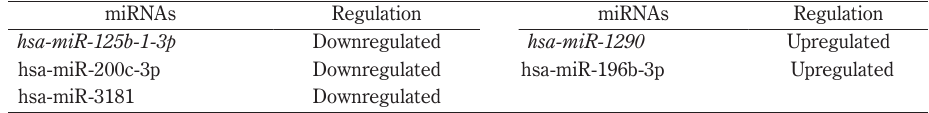
Table 4 Circulating miRNAs that showed significantly different expression levels in patients with heart failure before cardiac rehabilitation compared with patients with heart failure after cardiac